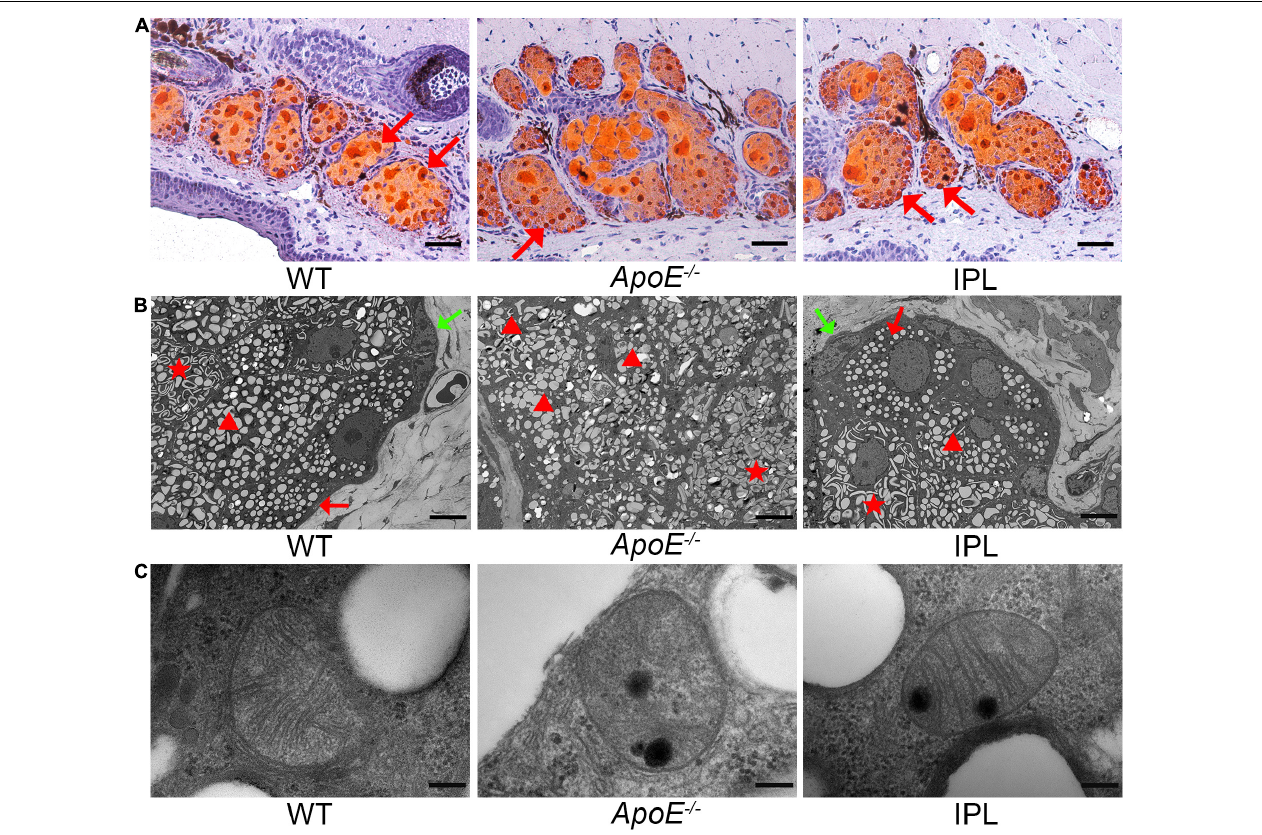
FIGURE 3 | Lipid droplets and mitochondrial ultrastructural changes after IPL treatment. (A) ORO staining showing increased hyperchromatic lipid droplets in the MG acini in IPL-treated mice. The red arrow indicates the lipid droplets. (B) Transmission electron microscopic images of lipid droplets in acinar cells. The green arrow indicates the absence of lipid droplets in the cytoplasm of undifferentiated cells. The red arrow indicates small, round and regular lipid droplets within cells in the early stages of differentiation. The triangle indicates large and irregular lipid droplets in the middle or late stages of differentiation. The star indicates enlarged and fused lipid droplets within differentiated cells. (C) Transmission electron microscopic images of mitochondrial ultrastructure in MG acinar cells. Scale bars: 50 µ m (A) ; 5 µ m (B) ; 200 nm (C)